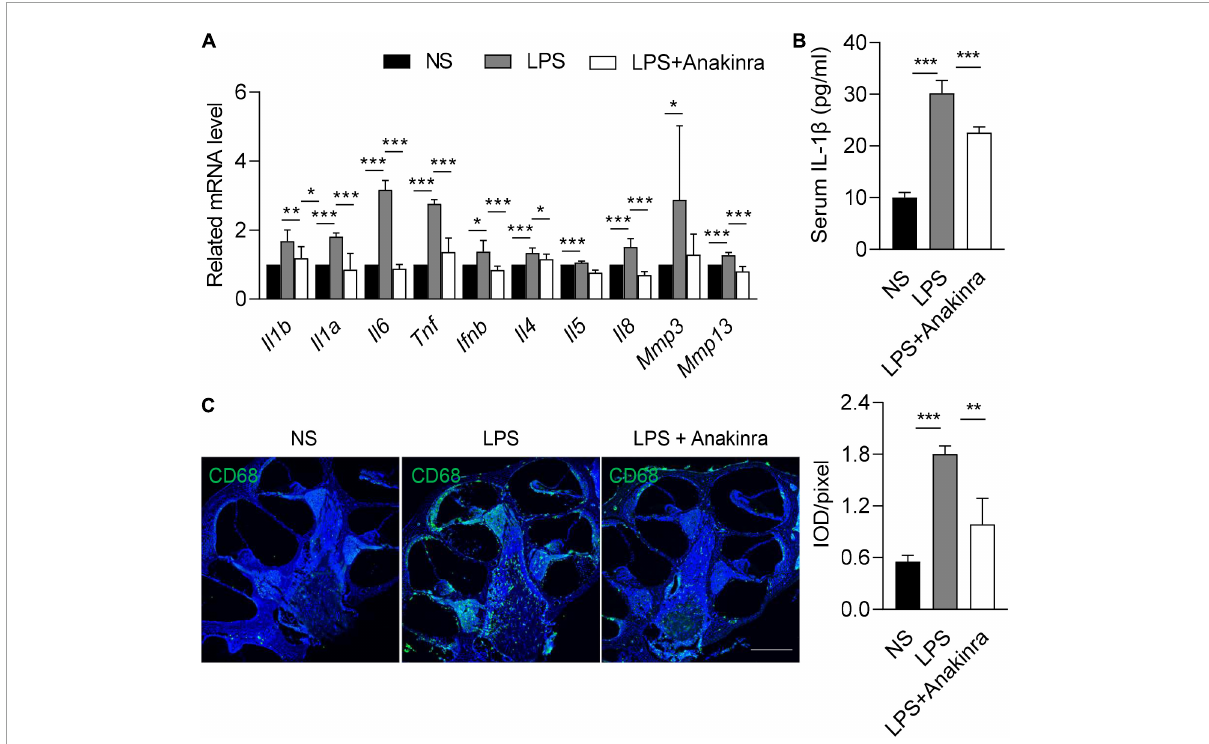
FIGURE5 Anakinra inhibited LPS-induced inflammation and macrophage infiltration. (A) Related mRNA expression level in cochlea ( n = 5). (B) ELISA for serum IL-1 β levels ( n = 5). (C) Immunofluorescence staining and quantification for CD68 (green) and DAPI (blue) in mid-modiolar cochlear sections. Analysis of images is shown at right, quantifying the load of CD68 per pixel ( n = 3), scale bar = 500 µ m. Data are presented as mean ± SD. * p < 0.05, ** < 0.01 *** p < 0.001. NS, 0.9% normal